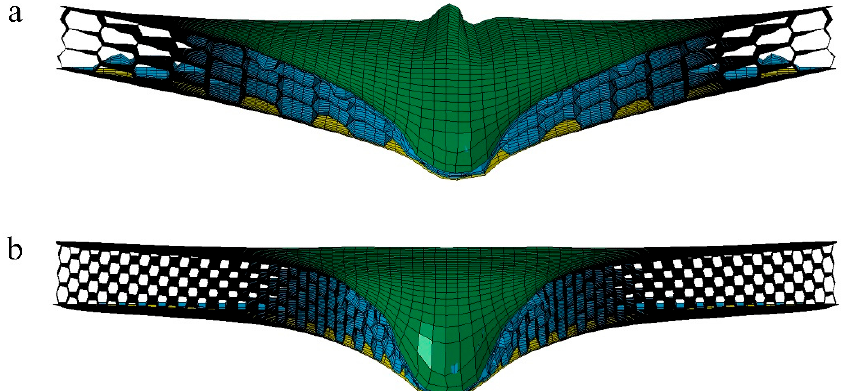
Figure 10. Deformation of the honeycomb structure with different geometric parameters under 100 m/s impact speed: ( a ) t/l = 0.07, θ = 30°; ( b ) t/l = 0.04, θ = 15°. 100 m/s impact speed: ( a ) t/l = 0.07, θ = 30 ◦ ; ( b ) t/l = 0.04, θ = 15 ◦